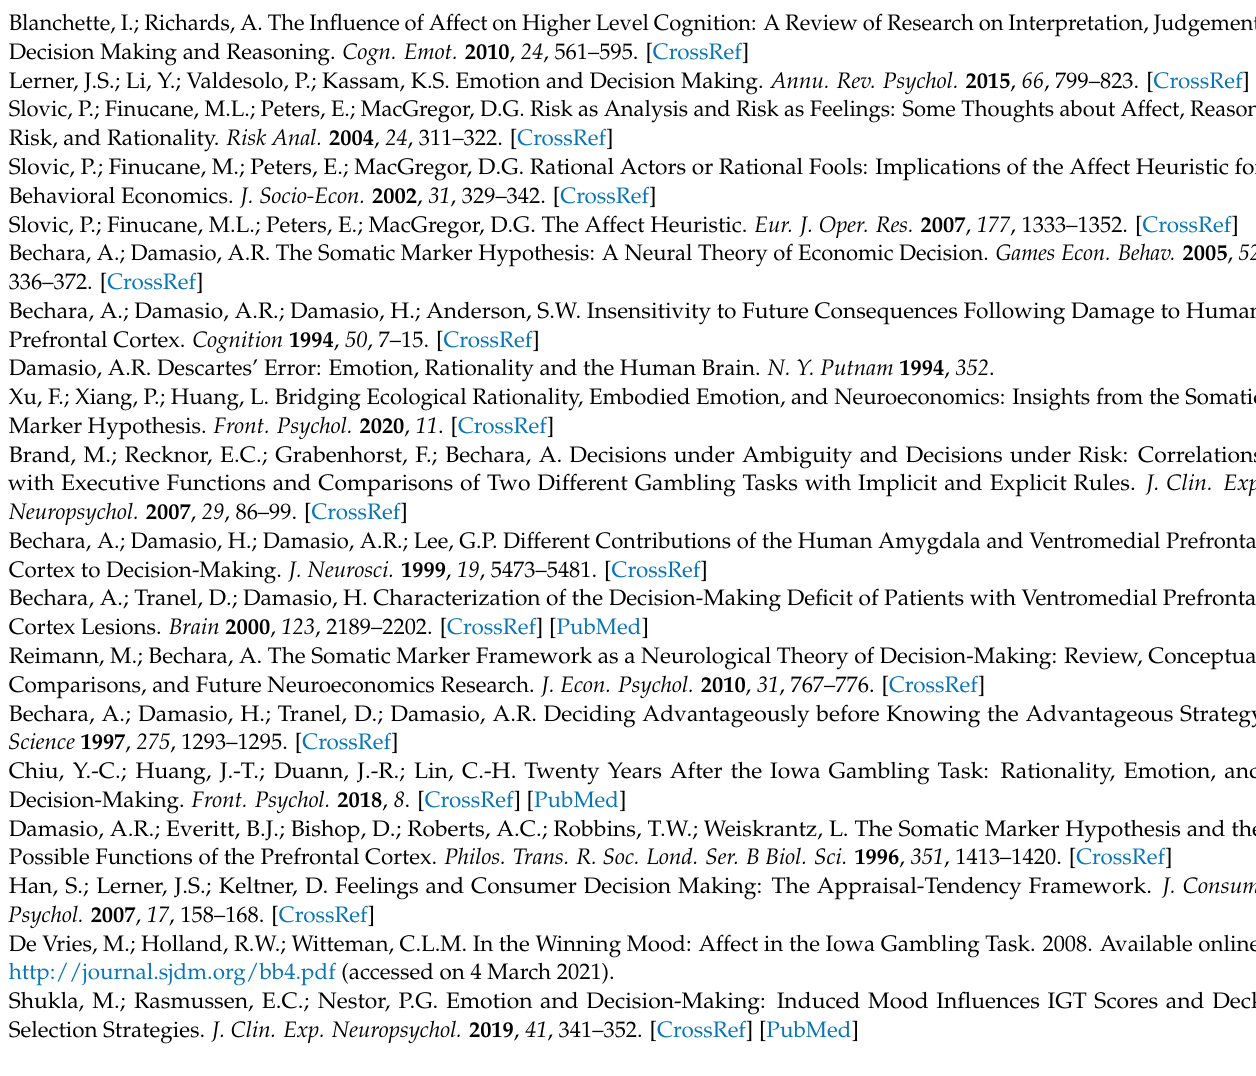
Table S3: Full model for anticipatory SCR. Table S4: Full model for